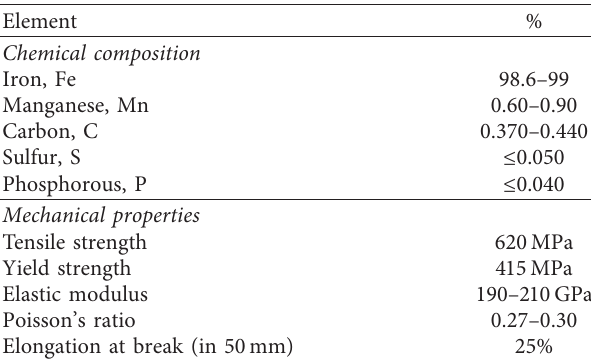
Table 1: Properties of AISI 1040 steel [37].